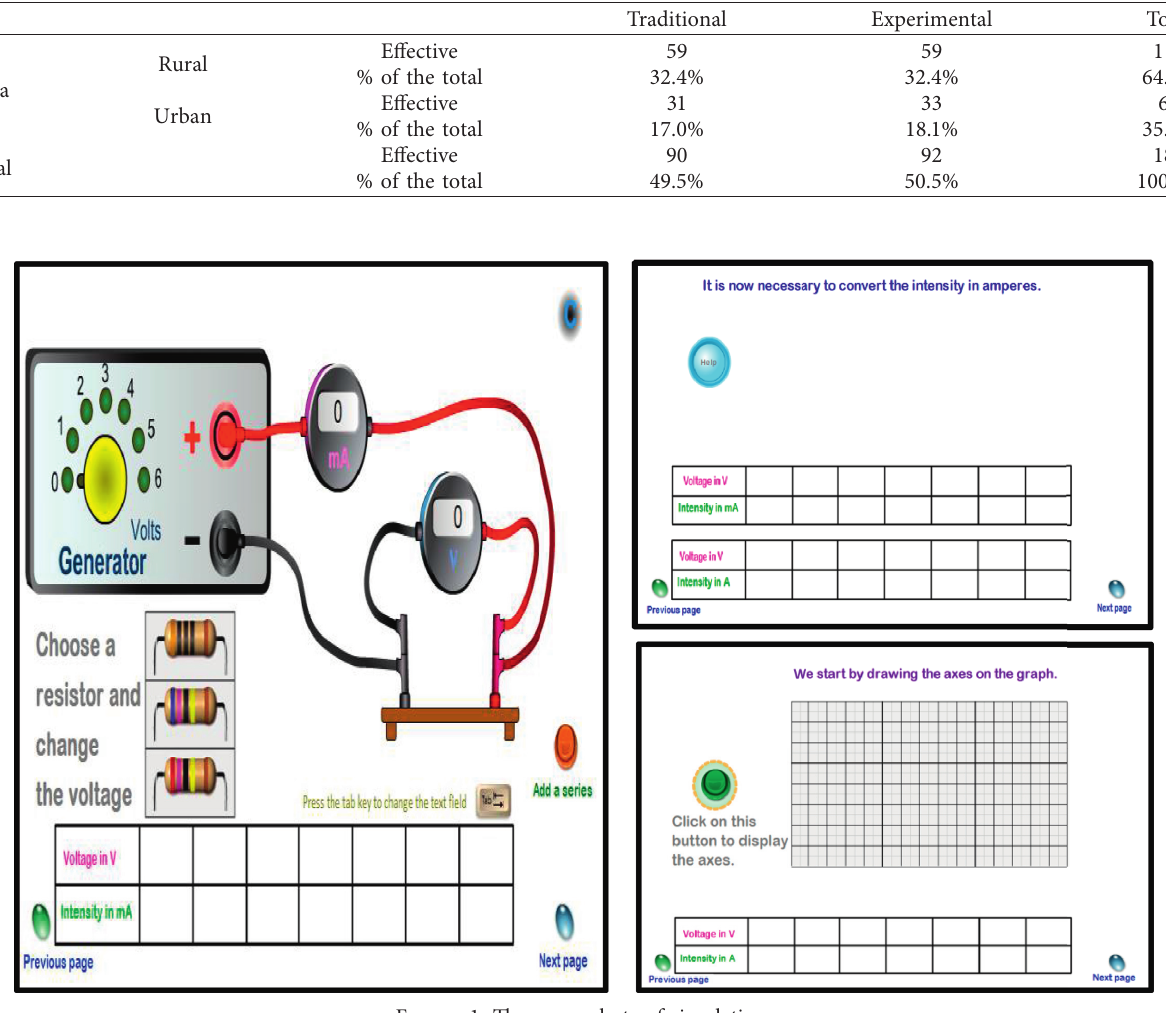
Figure 1: The screenshots of simulation.